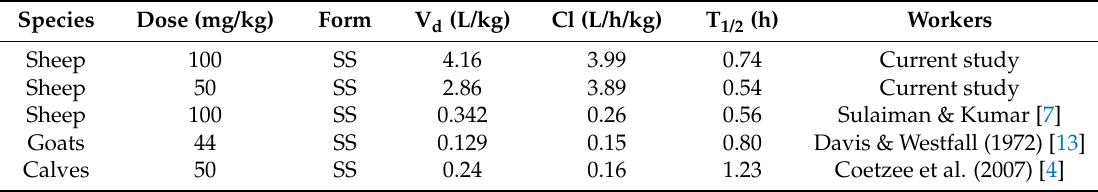
Table 3. Pharmacokinetic parameters of SS in different animal species after IV